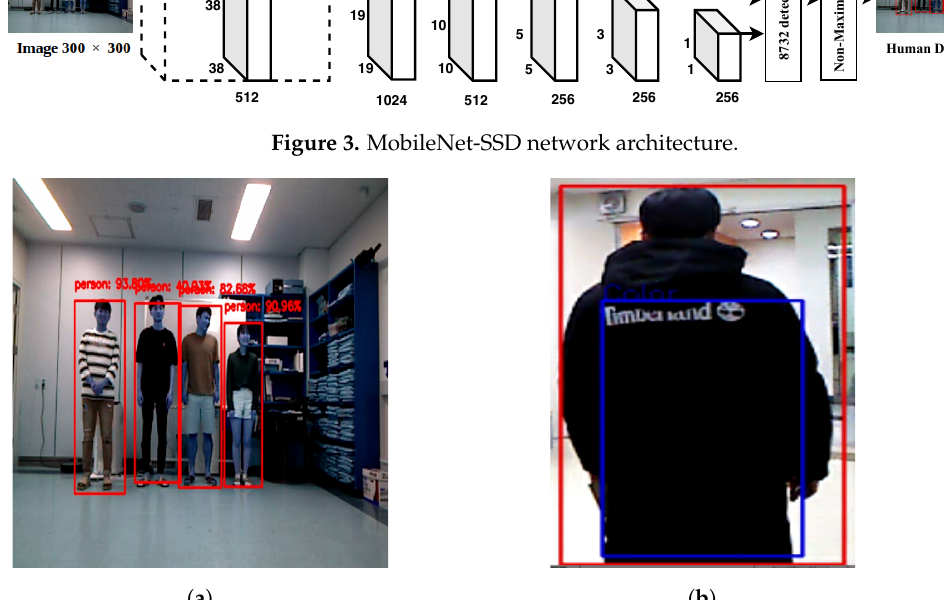
Figure 4. Human detection showing boundary boxes around the human’s body and region of interest. ( a ) Human detection. ( b ) Region of interest for color